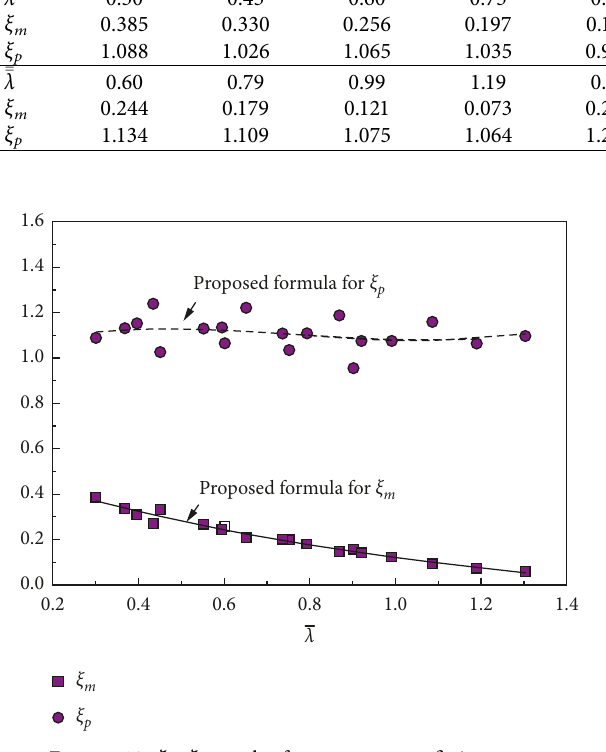
Figure 13: ξ p , ξ M as the form parameter fitting curve.